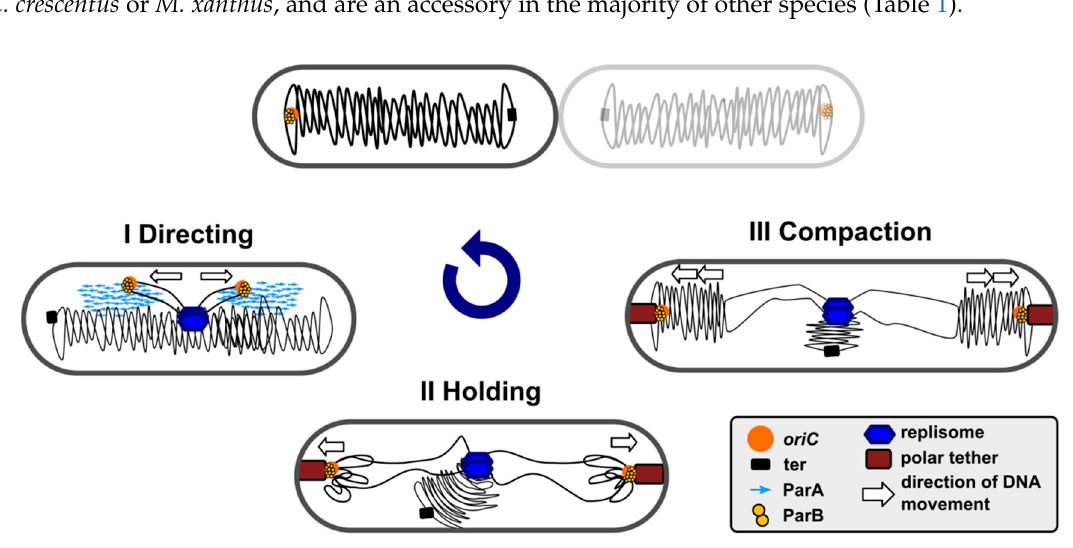
Figure 1. Involvement of partition ParB protein in ori domain re-locations, structuring and positioning during bacterial cell cycle.simplified scheme for P . aeruginosa -like longitudinal chromosome rearrangements is presented, in which the replisome is located in the cell centre, and the ParB-bound ori domains are anchored close to the cell poles before division [30].